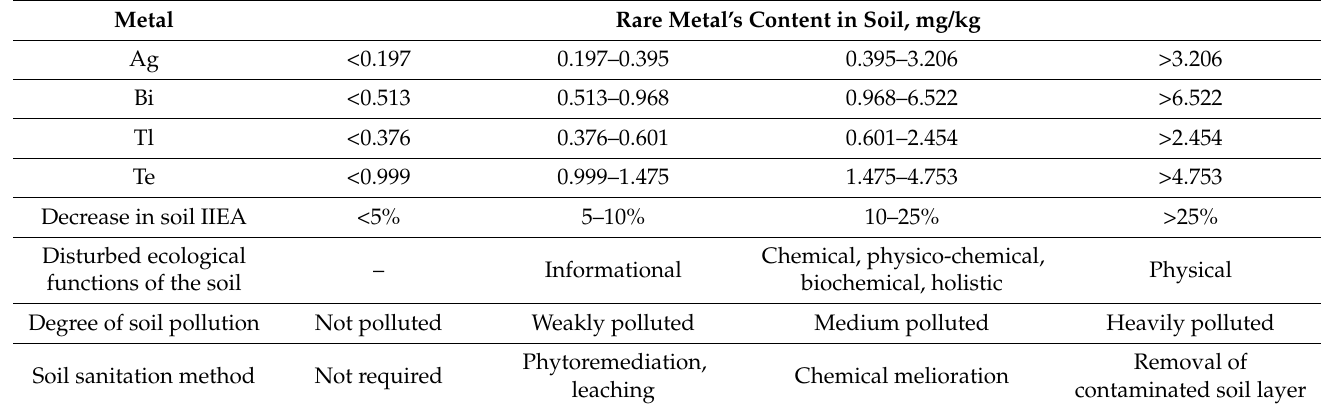
Table 4. Scheme of ecological regulation of the content of Ag, Bi, Tl, and Te in ordinary chernozem according to the degree of violation of ecological functions and optimal methods of soil